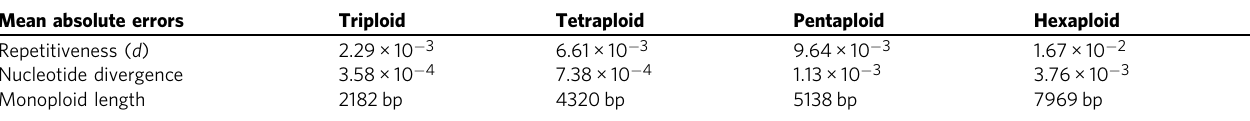
Table 1 Mean absolute errors of parameters on simulated polyploid datasets. Mean absolute